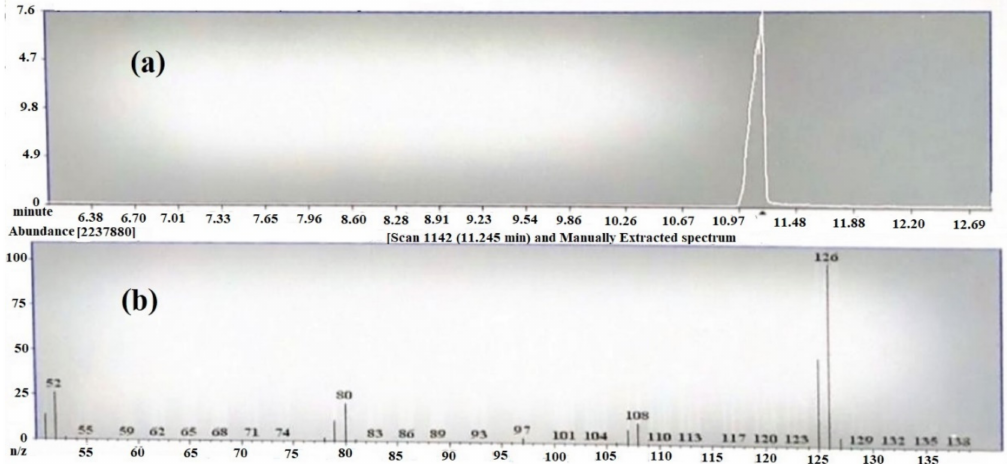
Figure 2. ( a ) TIC chromatogram of epigallocatechin-3-gallate (EGCG) by GC-MS and ( b ) mass spectrum of 1,2,3-benzenetriol.